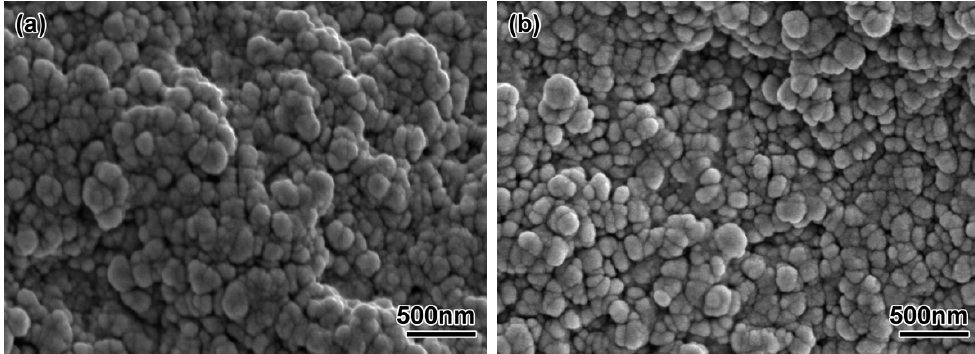
Figure 4. SEM micrograph of the ZrO 2 feedstock with different particle sizes: ( a ) 200 nm, ( b ) 100 nm. Table 2. Density deviation of the ZrO 2 feedstock with different particle sizes.